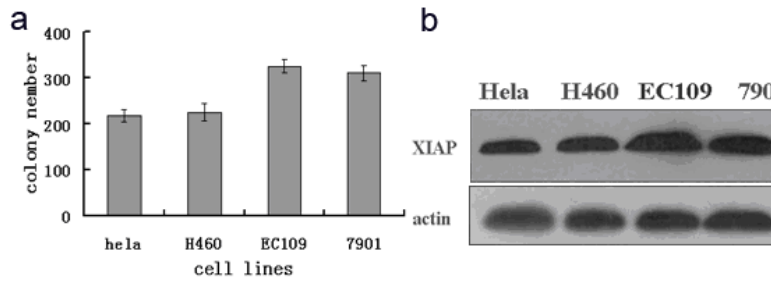
Figure 1. Relationship between XIAP expression of radiation-induced tumour cells and tumour radiosensitivity ( a ) Colony number of tumour cells after exposure to γ -ray; and ( b ) Western blot of the HeLa, H460, EC109 and 7901 tumour cell lines probed with antibodies to XIAP and β